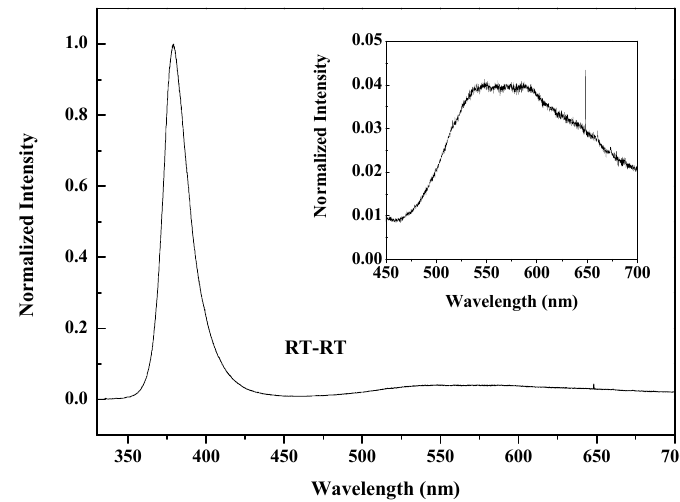
Figure 7. Normalized photoluminescence (PL) spectra of ZnO:N film prepared by oxidizing Zn 3 N 2 film grown at RT. The insert shows the enlargement of the visible region.